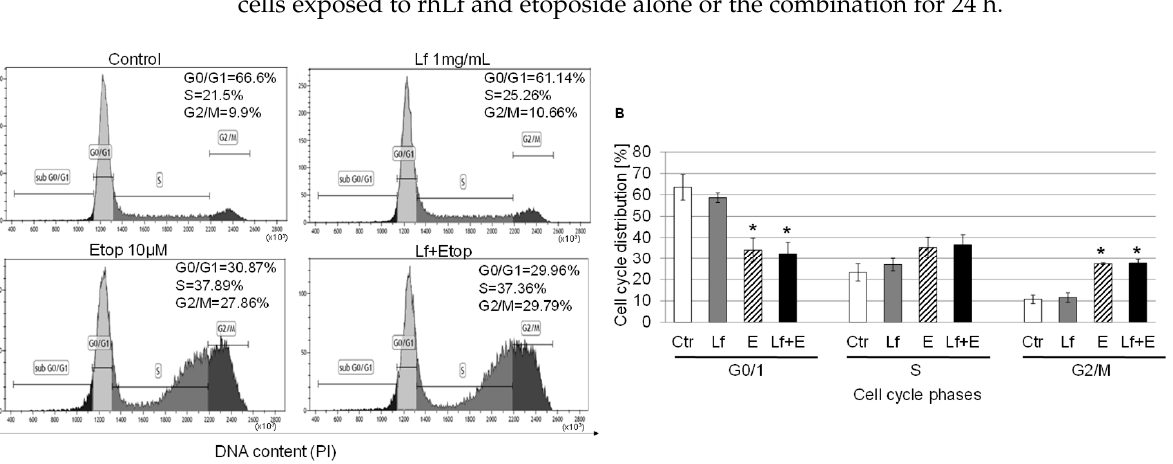
Figure 4. Effect of rhLf in combination with etoposide on A549 cell cycle progression. A549 cells were treated with rhLf (Lf) and etoposide (E) alone or the combination (Lf + E) at indicated concen- trations for 24 h. ( A ) Representative histograms show the cell cycle distribution at G0/1, S, and G2/M phases in the control and treated cells. ( B ) The bar graph indicates the percentage of cells at each